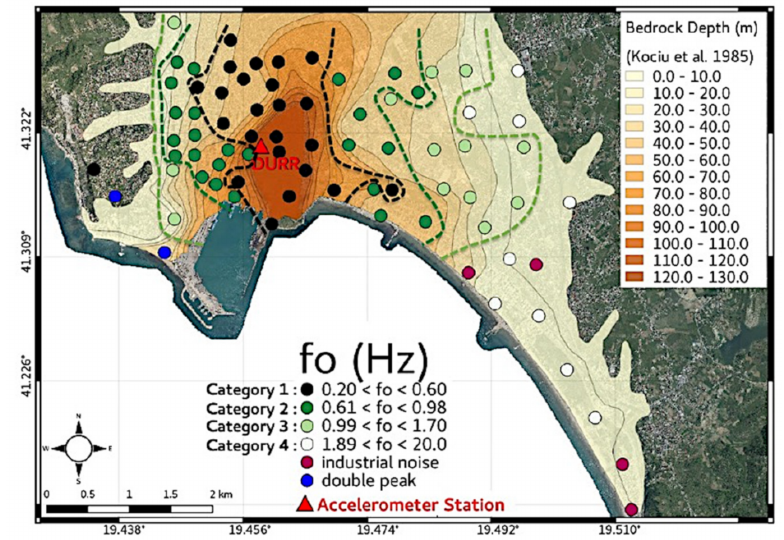
Figure 17. Spatial distribution of the four HVSR site categories in the city of Durres, together with iso-depth contours. Bedrock depth iso-contours by